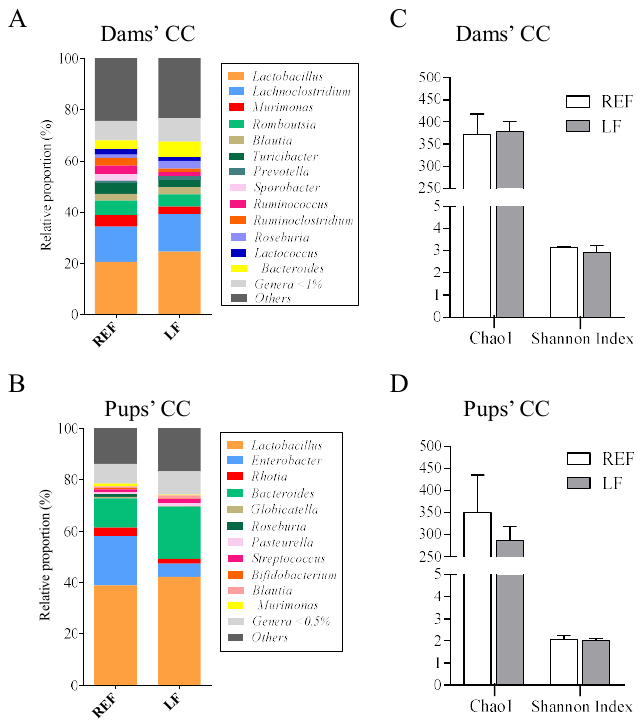
Figure 5. Cecal microbiota composition of dams’ and pups’ cecal content at L14. The main genera present in the cecal content are represented in stacked bars for ( A ) dams and ( B ) pups. Moreover, the richness of species and diversity of genera was analyzed by the calculation of Chao1 and Shannon Index, respectively, both for ( C ) dams and ( D ) pups. Results are expressed as mean ± S.E.M. ( n = 3 animals / group). REF, reference group; LF, Lactobacillus fermentum CECT5716 group; CC, cecal content.